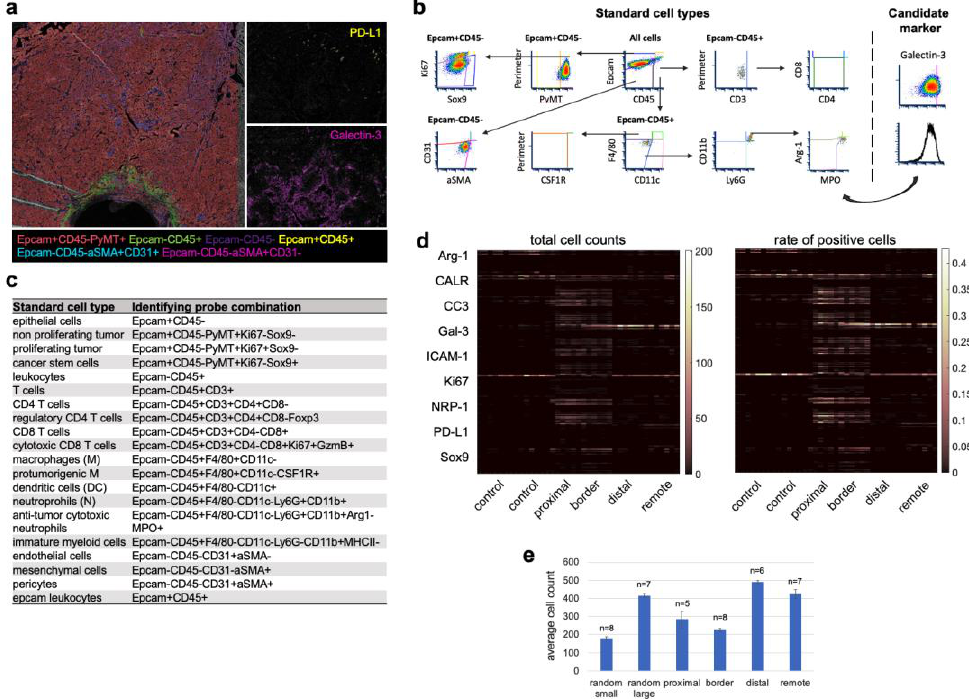
Figure 4. Analytical design to quantify the cell type specificity and spatial enrichment of ICB biomarkers at the panobinostat well. ( a ) Pseudo-colored image of a tumor sample implanted with a microdevice releasing panobinostat for three days. Marker combinations define the main tumor cell types: tumor (red), leukocytes (green), pericytes (cyan), fibroblasts (magenta). ( b ) Density plot of dimensionality reduction in hierarchical gating to define “standard cell types”. Candidate ICB biomarkers were measured within these cell subsets. The threshold for positivity was determined manually using FCS Express 6 and 7 image cytometry software and a positive control tissue. ( c ) List of probe combinations identifying standard cell types. ( d ) Heatmap of total cell counts (left) and rate of positive cells (right) at depicted panobinostat zones (x-axis). The control region was derived from the same section but in a panobinostat-non-affected area. ( e ) Bar graph showing the average cell count per analyzed zone and the number of replicates used ( n ). Bars are means ± s.e.